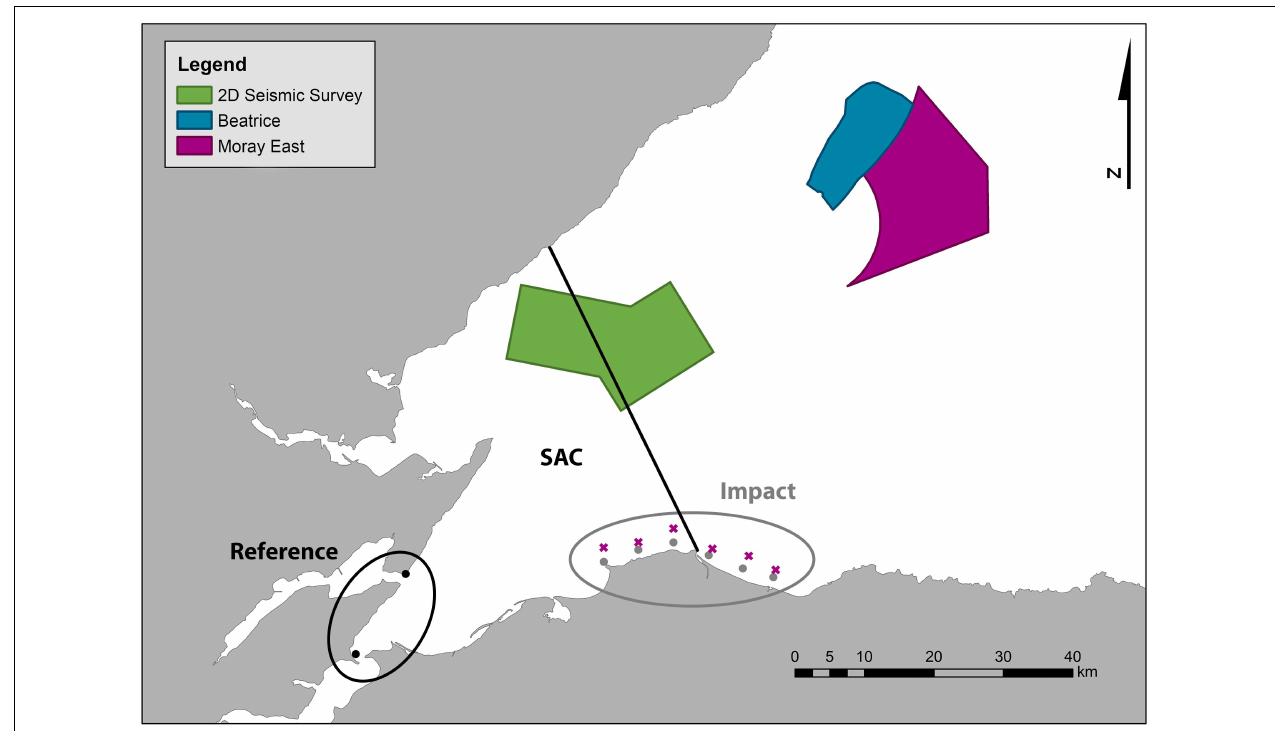
FIGURE 1 | Map of the Moray Firth showing the boundary of the Moray Firth SAC (solid line) and the areas in which different offshore projects were undertaken (2D seismic survey and Beatrice and Moray East wind farms). Circles ( • ): CPODs deployed from 2009 to 2019 (circled in black: Reference Area array; circled in gray: Impact Area array); X-shaped crosses (x): CPODs deployed in 2019 only ( Impact Outer array).